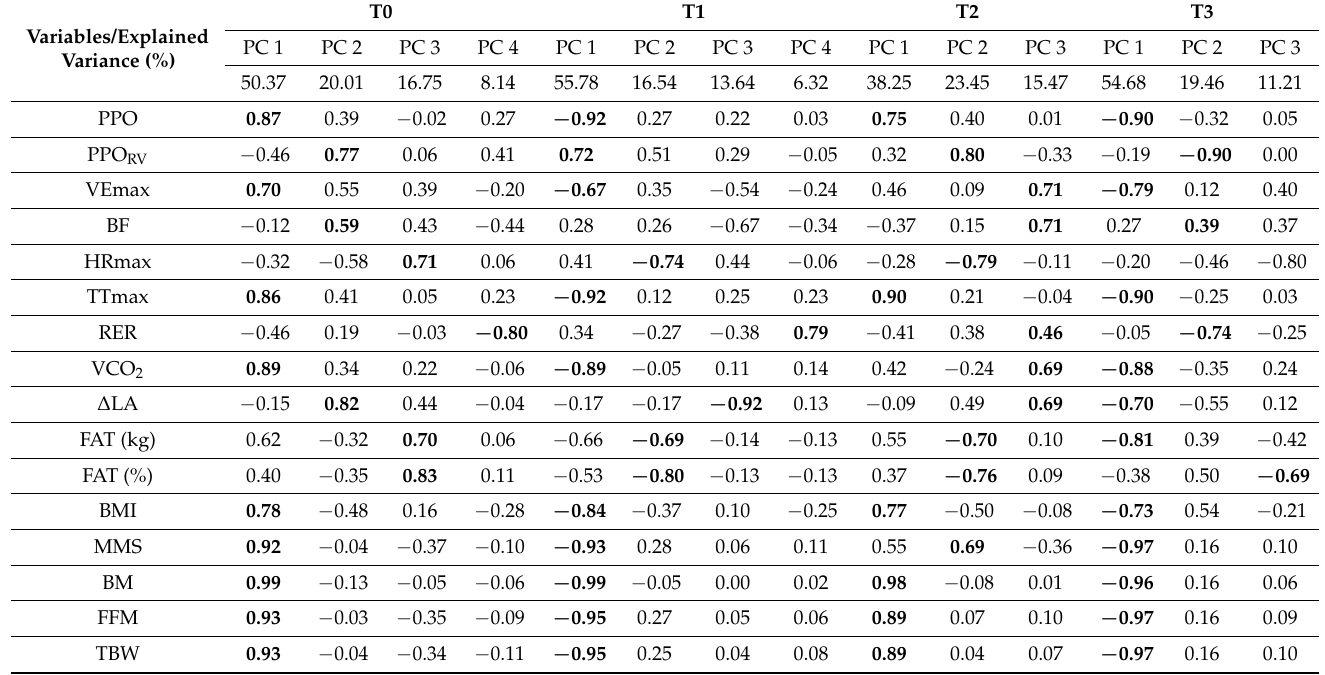
Table 4. Results of the principal component analysis (PCA) for individual periods of training. Table explains the variance and structure of factor changes for 16 features and isolated principal components (PC). In bold, the correlation values of the characteristics most strongly associated with the isolated factors are